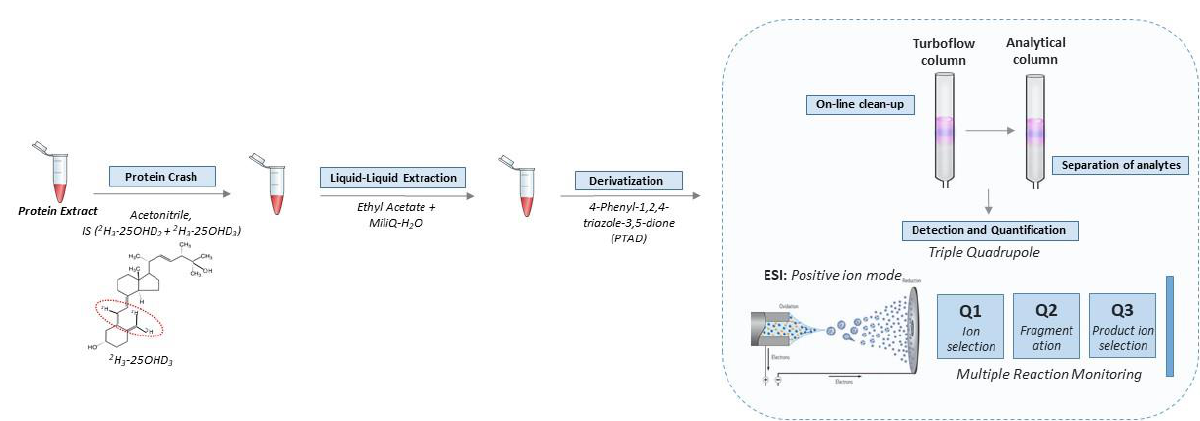
Figure 1. Workflow for quantification of vitamin D metabolites in leftover protein extract from DBS. Briefly, the vitamin D metabolites were extracted and derivatized with PTAD prior to entering the automated LC-MS/MS setup. The LC part consists of a combination of a TurboFlow column and an analytical column in order to reduce ion suppression and separate the vitamin D metabolites, respectively. Subsequently, detection and quantification were achieved in positive ion mode in a triple quadrupole mass spectrometer equipped with MRM. The approach was further optimized to be used in high throughput.